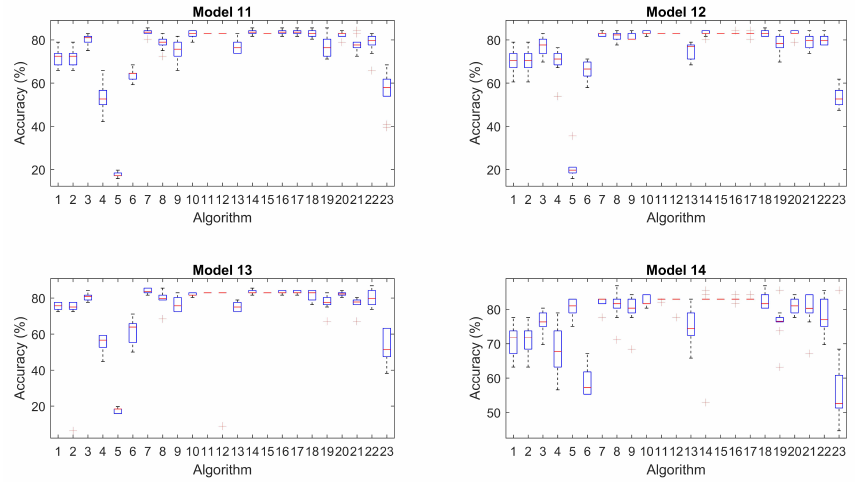
Figure 6. Numerical simulation Assumption 3 (Constant). Accuracy of various models after permu- tations in the numerical values of the mapping. The 23 algorithms are represented in the x -axis, and the accuracy is shown in the y